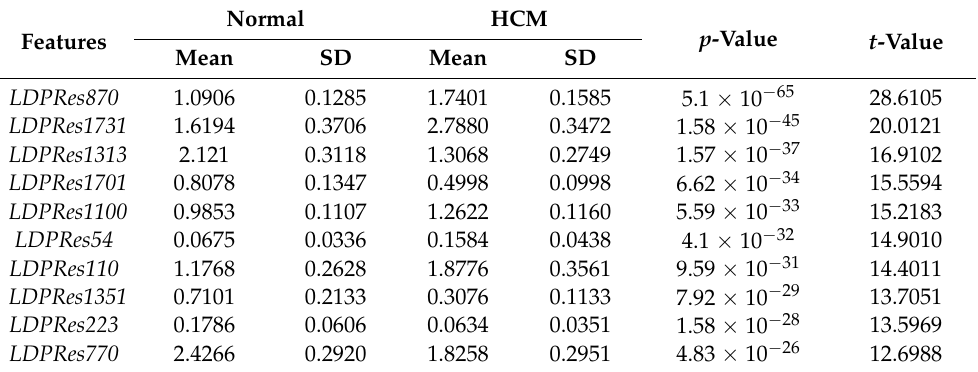
Table 1. Ranked Features with Means, Standard Deviations (SD), and p - and t -Values. Features